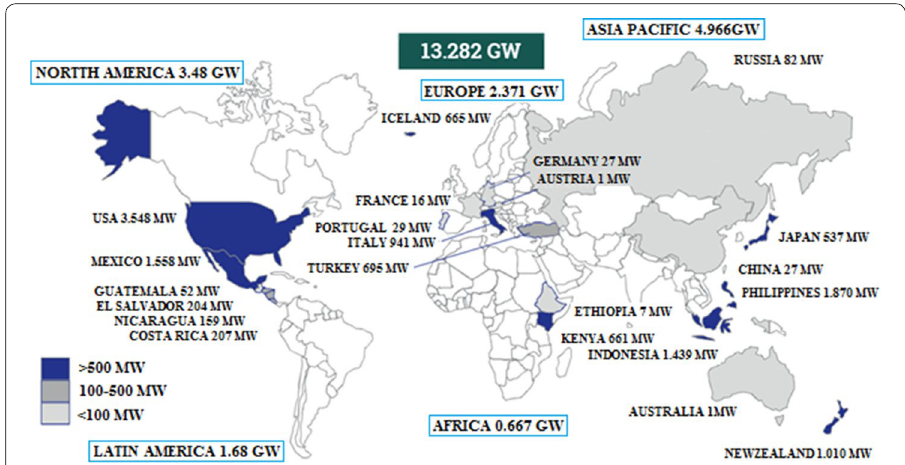
Fig. 1 Geothermal installed capacity (MW)—2016 (Reproduced with permission from Bertani 2016; ThinGeo- Energy